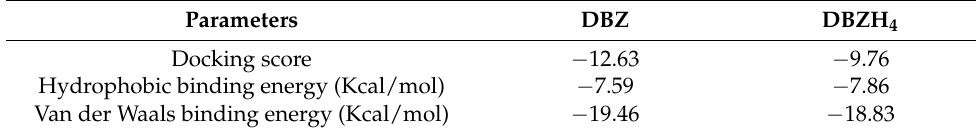
Figure 11. Docking simulations of DBZ and DBZH 4 against BSA (PDB code: 4F5S). ( a ) Ribbon representation of BSA showing the structural domains colored as indicated and the HP9 binding pocket (dark green mesh). ( b , c ) Protein–ligand interaction of DBZ ( b ) and DBZH 4 ( c ) at the indicated site showing the binding residues. ( d – f ) Molecular representations of the overlapped DBZ (orange) and DBZH 4 (green) at the binding site showing the twisting of DBZH 4 by a 98 ◦ angle from DBZ . Table 5. Molecular docking predictions of DBZ and DBZH 4